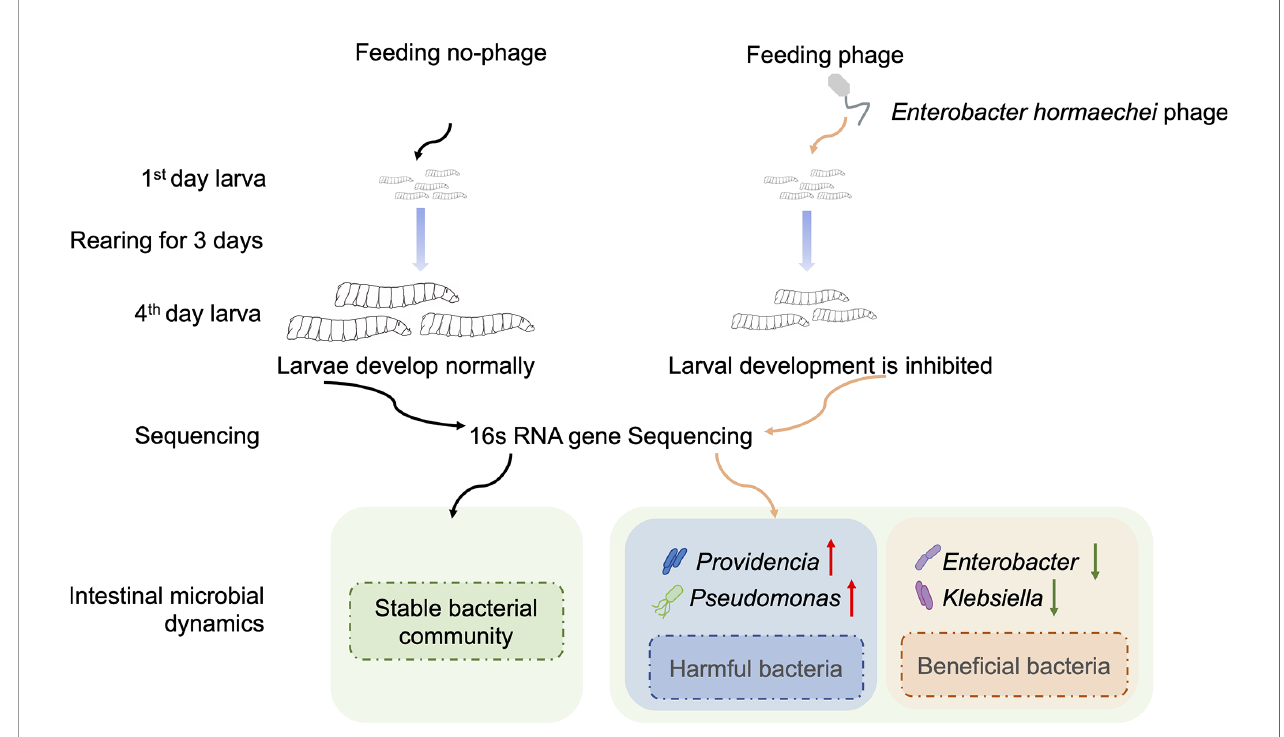
FIGURE 9 | Schematic diagram of the effect of phage on house fl y